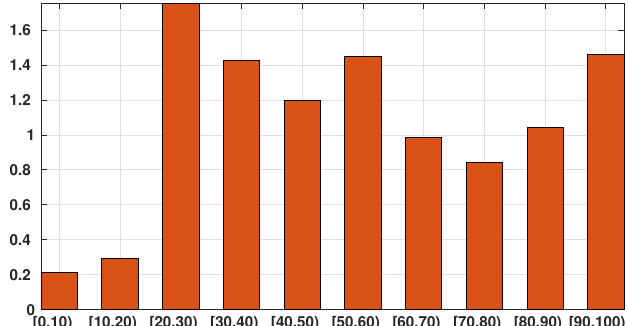
Figure 1. In this figure we plot in blue bars the age distribution of the Japanese population for 10,000 people and we plot in orange bars the age distribution of the number of reported cases of SARS-CoV-2 for 10,000 patient on 29 April (based on the total of 13,660 reported cases). We observe that 77% of the confirmed patients belong to the 20–60 years age class.